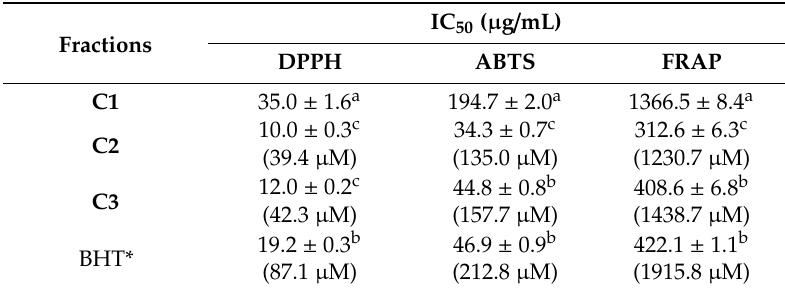
Table 4. Antioxidant activities measured by DPPH, ABTS (2,2 (cid:48) -azinobis-(3-ethylbenzothiazoline-6- sulfonic acid)) and ferric reducing antioxidant power test (FRAP) of EtOAc extract fractions from R. crispus root in term of IC 50 values.